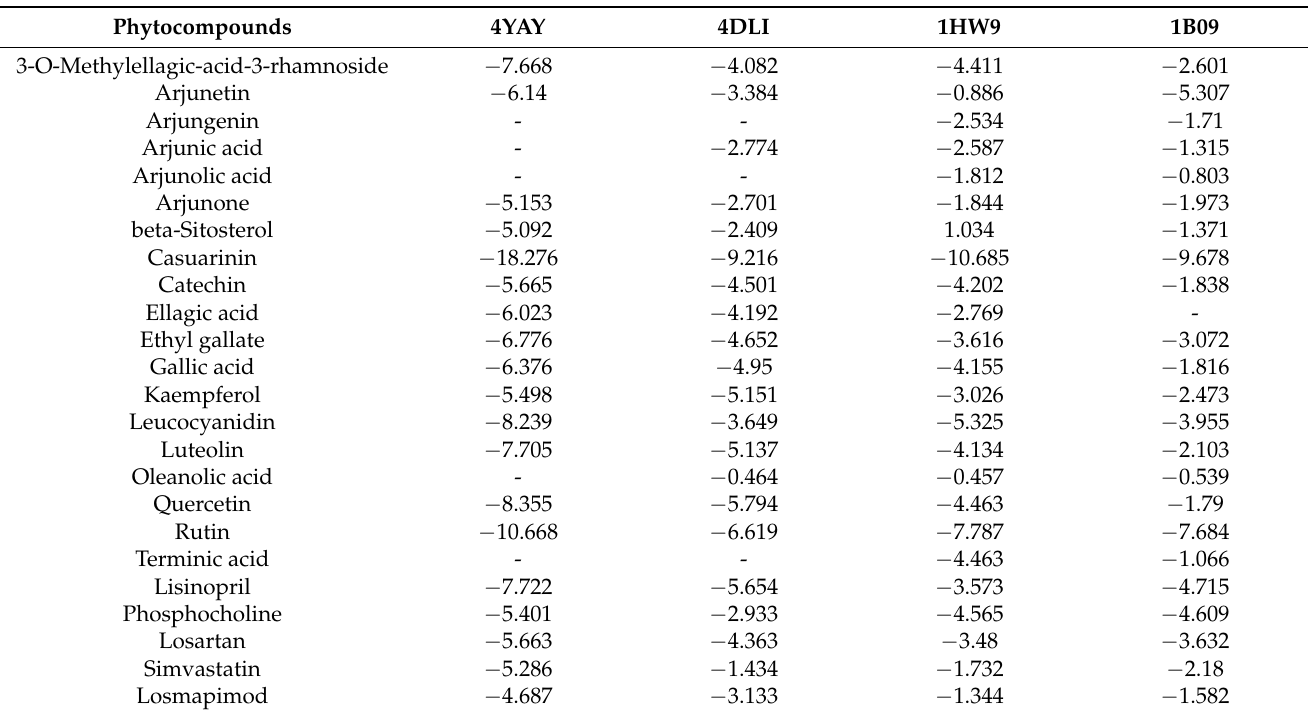
Table 1. Binding energy of docked phytocompounds from T. arjuna against targeted protein receptors. Binding energy was expressed in terms of kcal mol − 1 .